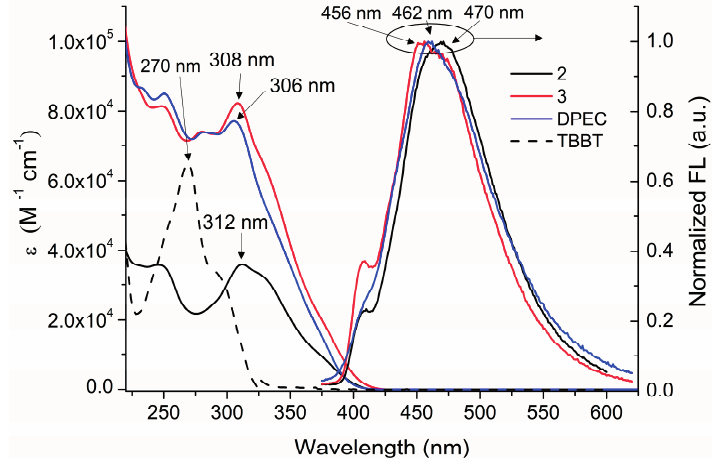
Figure 4. Absorption and emission spectra of dilute solutions of TBBT , 2 , 3 , and DPEC